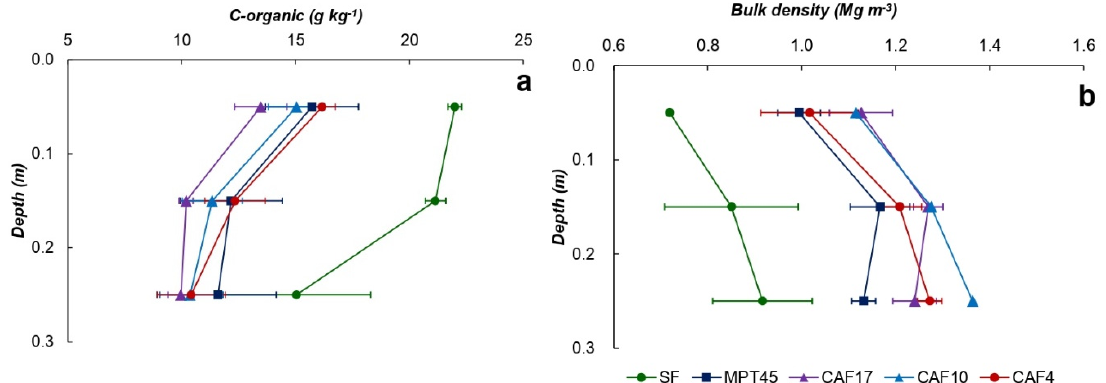
Figure 4. Surface soil (0–30 cm depth) soil organic carbon status ( a ) and bulk density ( b ) of secondary tropical forest (SF), multistrata agroforestry that is 45–68 years old (MAF45), cocoa agroforestry that is 17–34 years old (CAF17), cocoa agroforestry that is 10 years old (CAF10), and cocoa agroforestry that is 4–5 years old (CAF4). Bars are standard errors of the means.